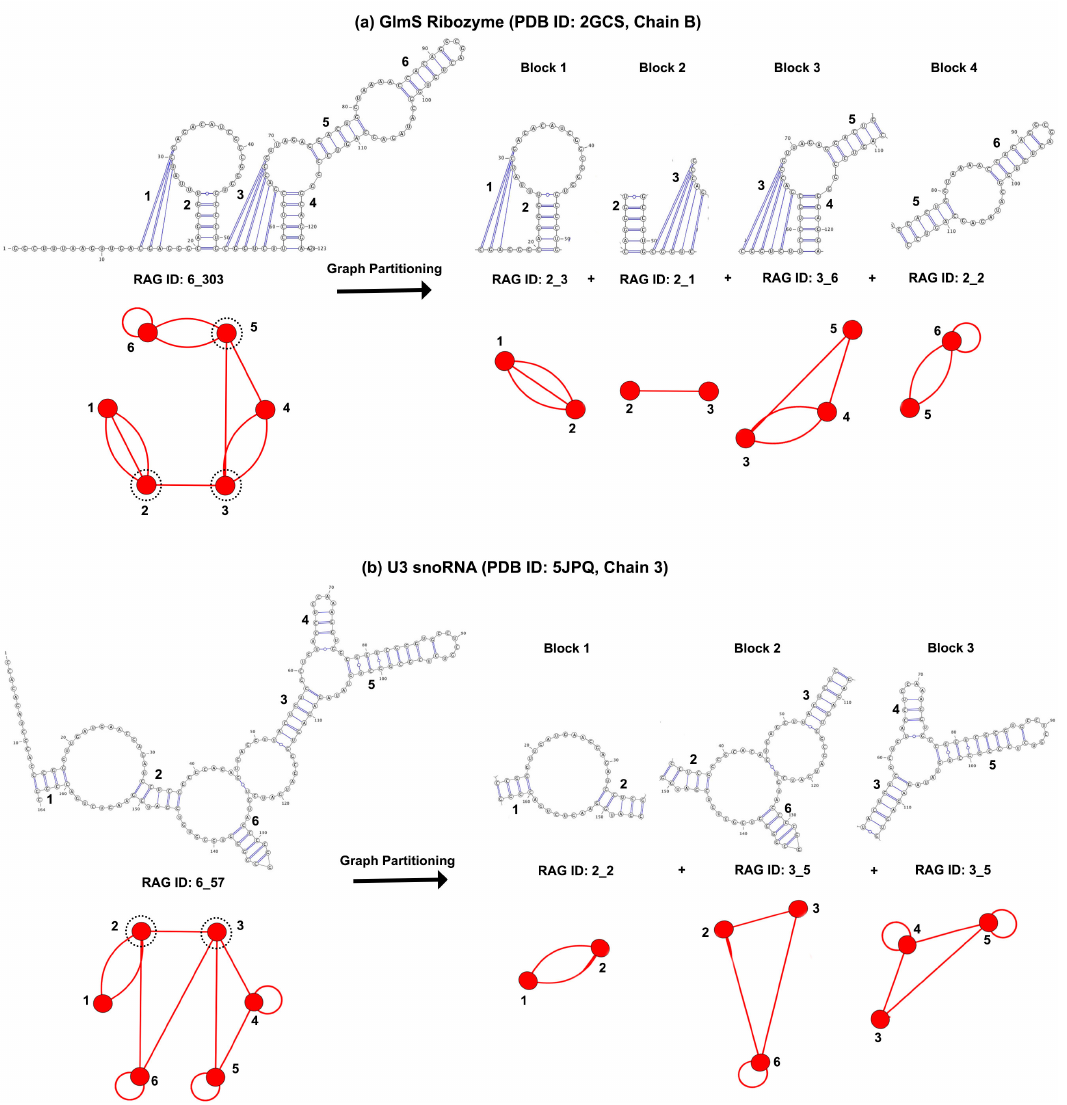
Figure 2. Dual graph partitioning. Illustration for ( a ) structure with pseudoknots; and ( b ) structure with junctions. Dashed black lines show the articulation points, where the graph will be